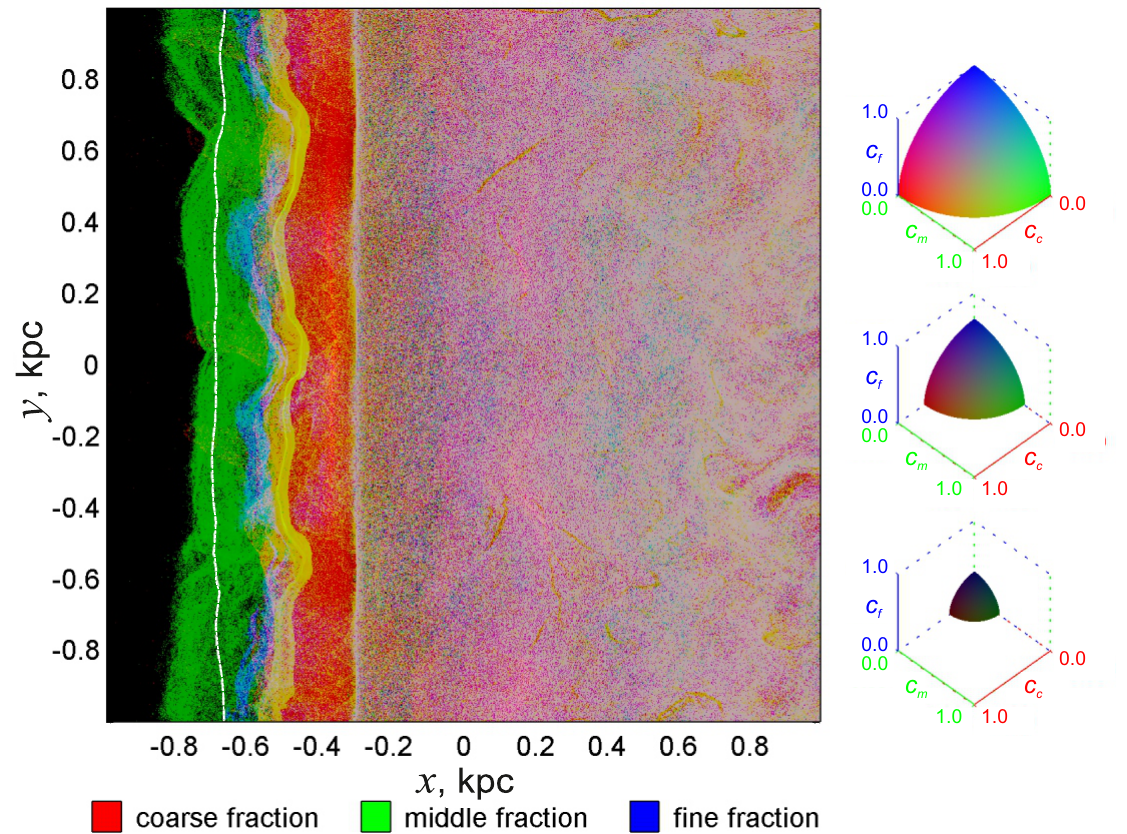
Figure 7. Synthetic image of a two-dimensional pattern of the flow of polydisperse dust in a turbulent gas-dust flow through a gravitational potential well of a spiral sleeve for the same time point as in Figure 6. The dust component contains three fractions, large dust particles (red color), dust particles of medium size (green color) and small particles (blue). To the right of the figure are the sections of the cubic palette of colors by spheres of different radii; see the caption to Figure 3. A detailed explanation of the construction of a color scheme for a mixture with arbitrary proportions between the concentrations is given in Section 3. The white dashed line indicates the position of the front of the galactic shock wave. A thin whitish line at x ≈ 0.3 corresponds to the position of a combined light and dust